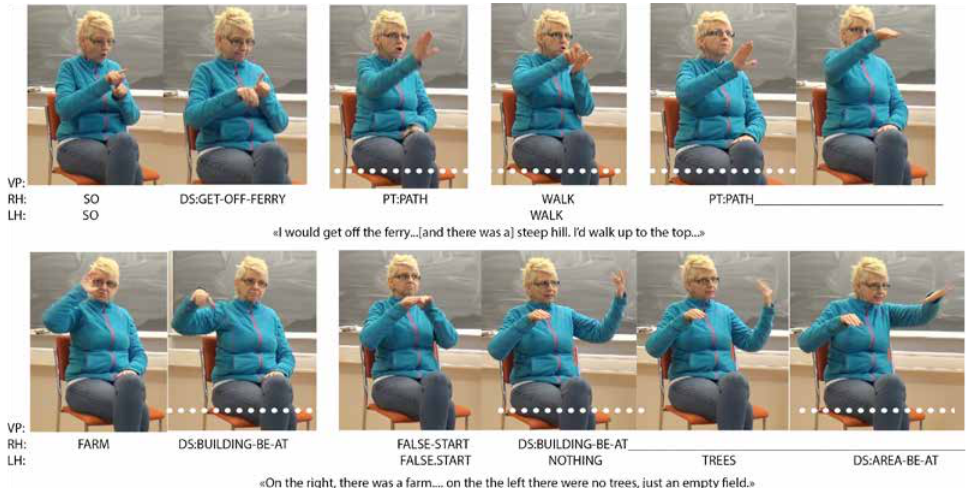
Figure 5: An example of a signer depicting from an internal, mobile vantage point (DPNTS_TR_HKO.eaf,